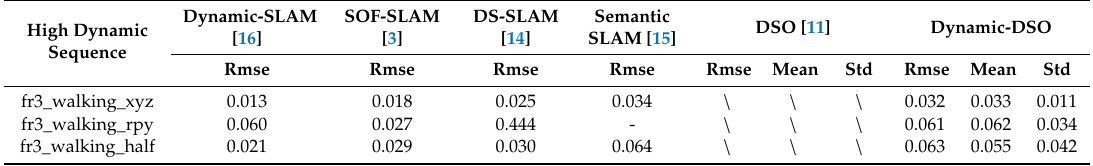
Table 1. Comparison of absolute Pose Error (APE) for translation part in public TUM dynamic dataset. (Unit: